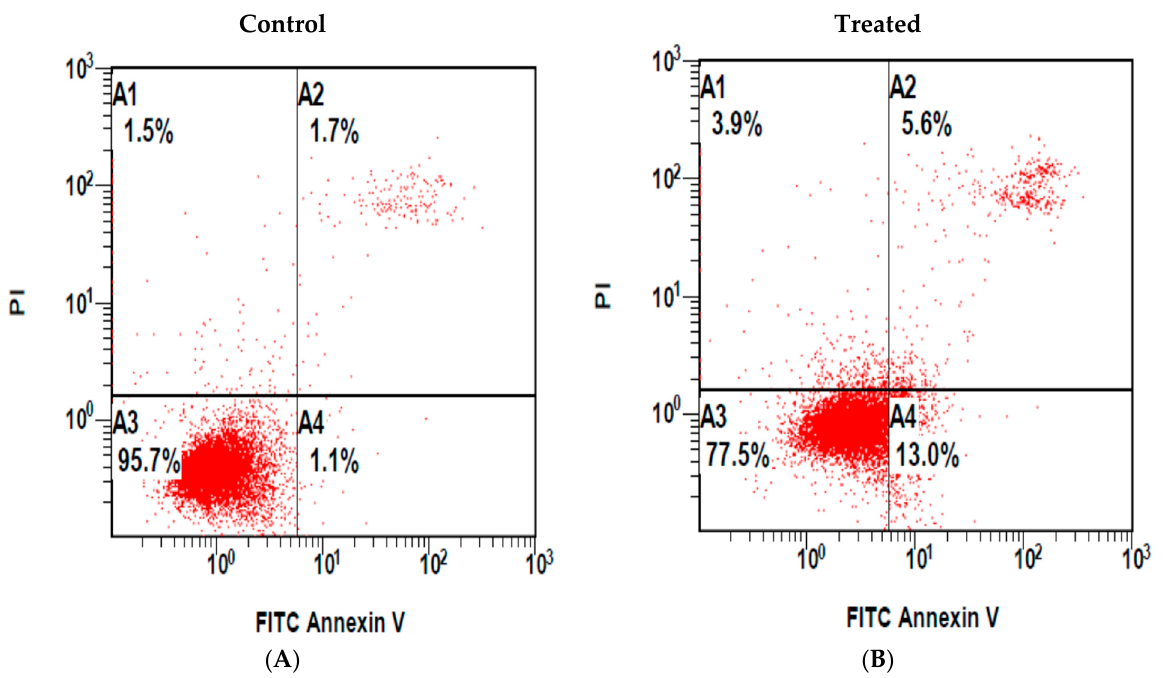
Figure 2. Detection of apoptosis by Annexin V-FITC/PI staining in methanol extract-treated cells. MDA-MB-231 cells were incubated for 24 h ( A ) without (control) and ( B ) with the methanol extract of shoots of M. sinaica and stained with both FITC and PI. Quadrant (A1) represents the necrotic dead cells, (A2) shows the late apoptosis cells, (A3) viable cells, and (A4) indicates early apoptosis.